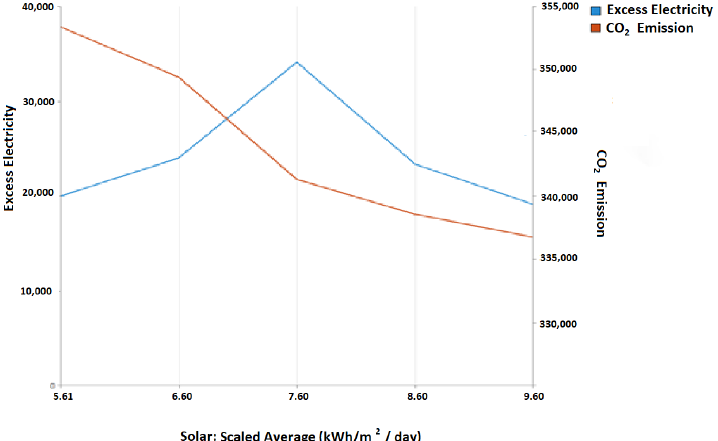
Figure 12. Sensitivity analysis for excess electricity and CO 2 emissions based on average solar radiation.